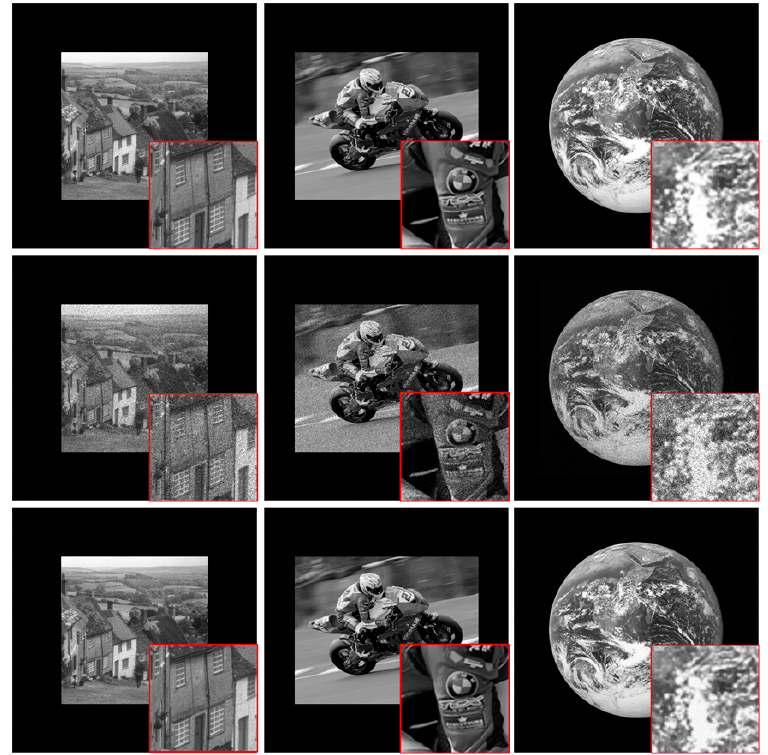
Figure 6. Numerical simulations: target images ( top ); reconstructed images with GS algorithm ( middle ) and WCIA ( bottom ). Image credits: Goldhill by USC-SIPI, Motorbike by Steve Sewell and Earth by WikiImages.